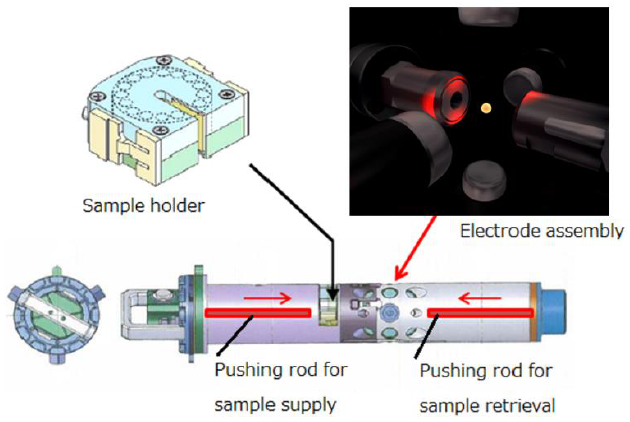
Figure 18. Details of the sample cartridge shown in Figure 17.